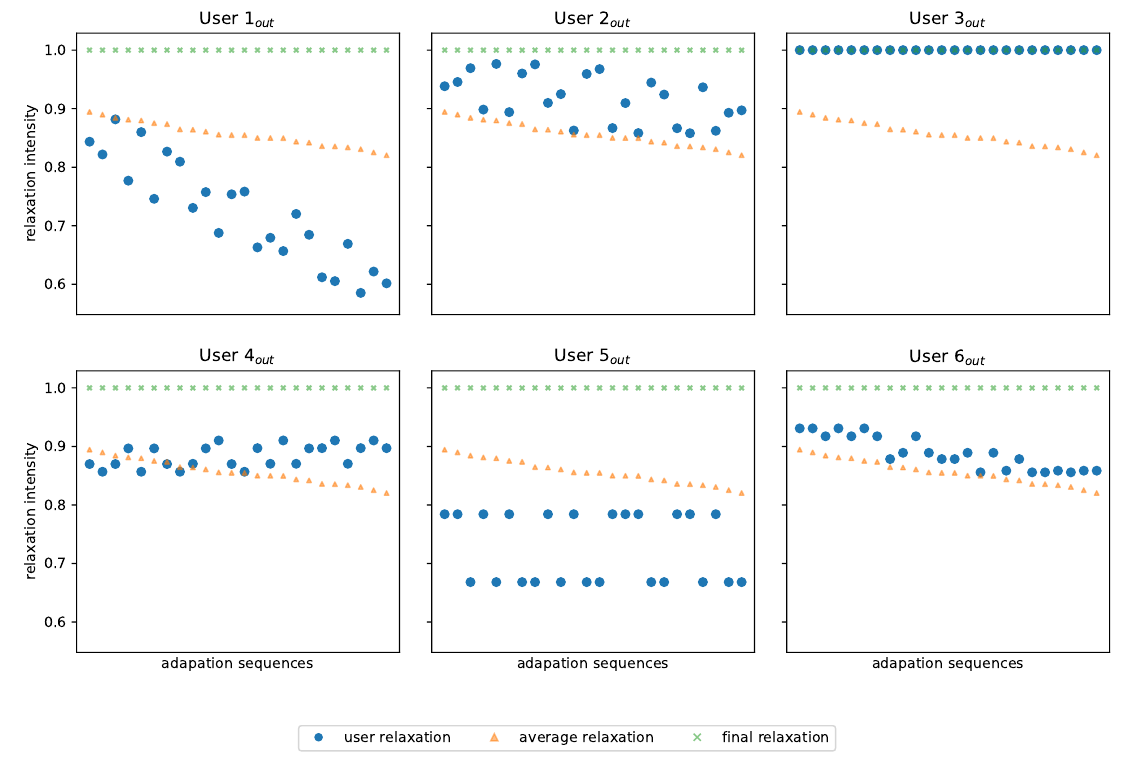
Figure 12. The average relaxation over all simulations plotted for every permutation of adaptations for the outdoor environment. The adaptation sequences are sorted according to decreasing final and average